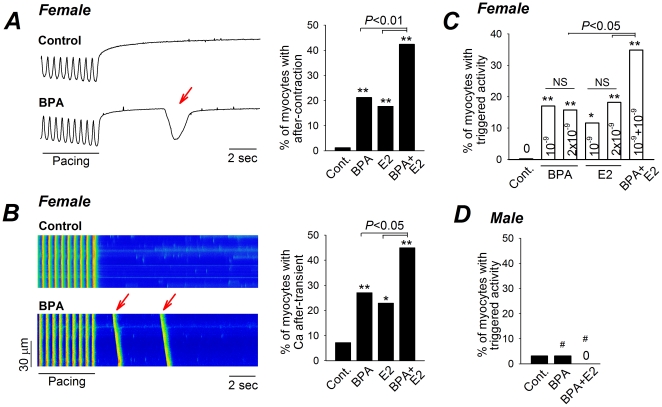
Acute exposures to BPA and E2 promote triggered activities in female rat ventricular myocytes.(A) Left, representative contraction traces of female rat myocytes elicited by pacing under control and upon acute exposure to 10−9 M BPA. Arrow indicates spontaneous after-contraction (i.e., triggered activity) following pacing. Right, percentages of myocytes with after-contractions under various conditions. N = 52–87 myocytes. (B) Left, representative Ca2+ transients in female rat myocytes elicited by pacing under control and upon acute exposure to 10−9 M BPA. Arrows indicate spontaneous Ca2+ after-transients (i.e., triggered activity) following pacing. Right, percentages of myocytes with after-transients under various conditions. N = 35–74 myocytes. (C) Percentages of female myocytes with triggered activities under BPA or E2 alone, at 10−9 and 2×10−9 M, and under a mixture of BPA and E2, both at 10−9 M; n = 42–66. (D) Percentages of male ventricular myocytes with triggered activities under control, 10−9 M BPA and a mixture of BPA and E2, both at 10−9 M, N =  32 myocytes for all groups. #: P>0.1; *: P<0.05; **: P<0.01 vs. control in a χ2 test. NS (not significant): P>0.1.